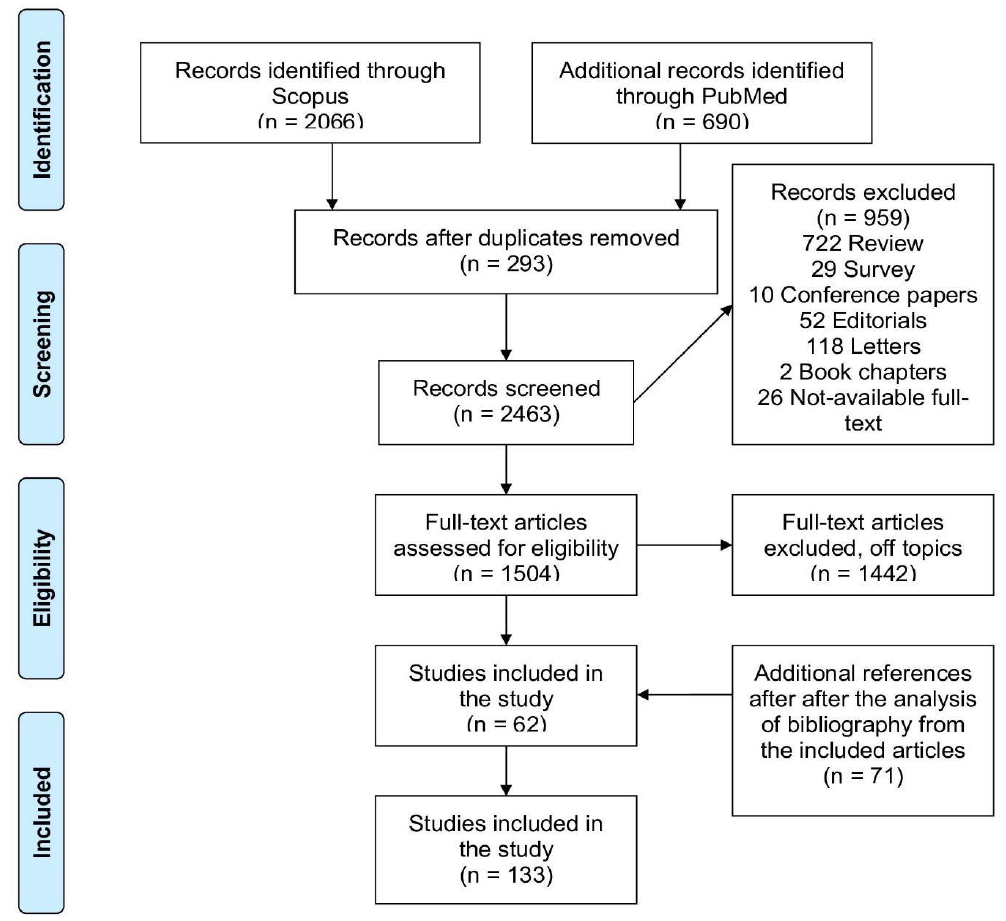
Figure 2. Flowchart detailing literature search according to PRISMA statement.